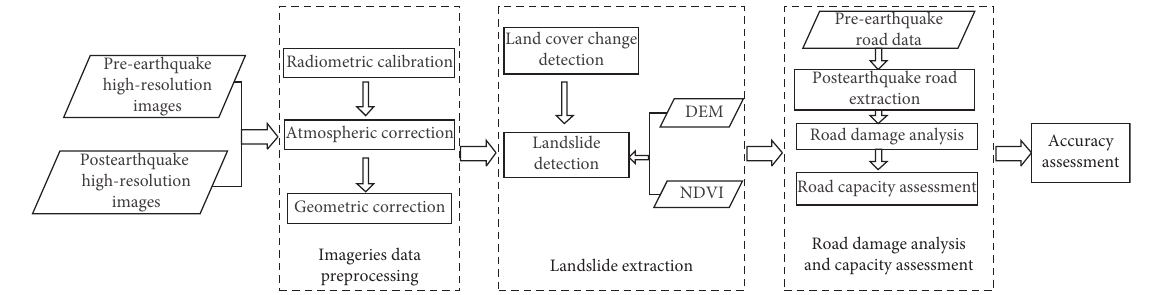
Figure 3: Flowchart of quick estimation of landslides and postearthquake road capacity. Table 2: Main natural land cover of Jiuzhaigou.